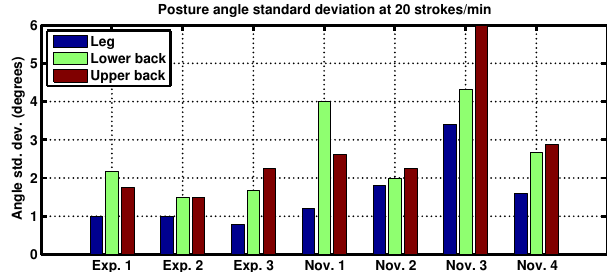
Figure 4: Posture angle standard deviation at 20 strokes/min.